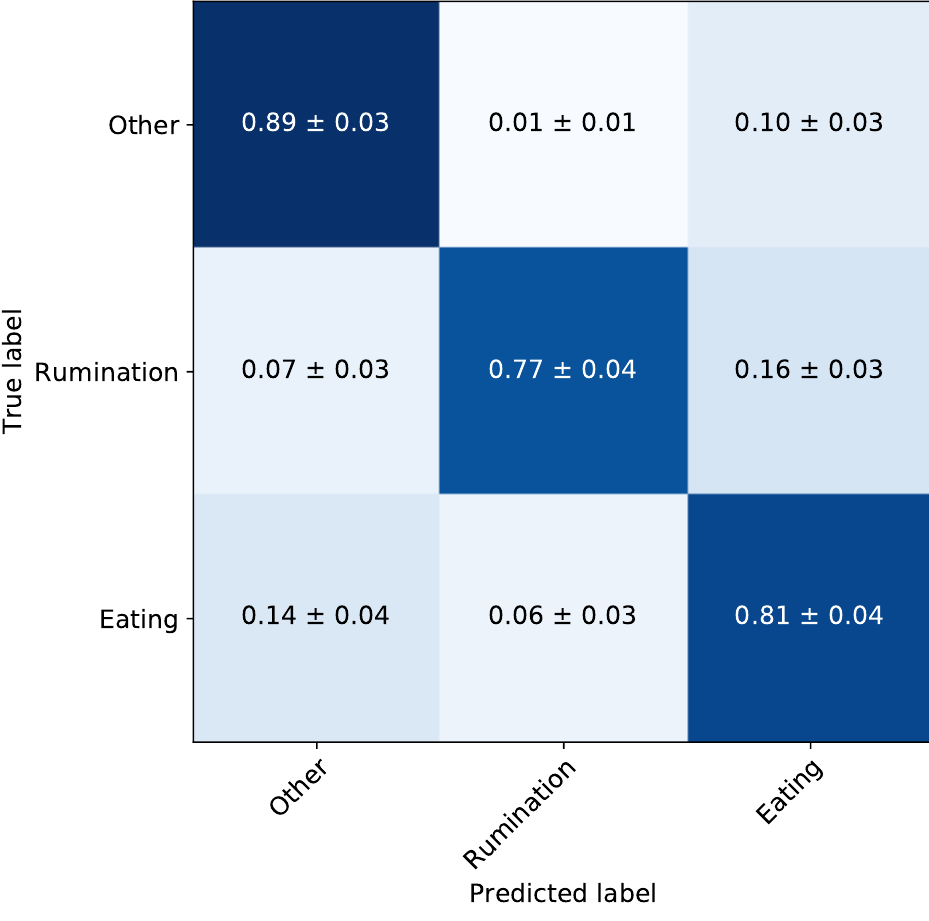
Figure 6. Confusion matrix of the full network after hyper-parameter tuning—validation